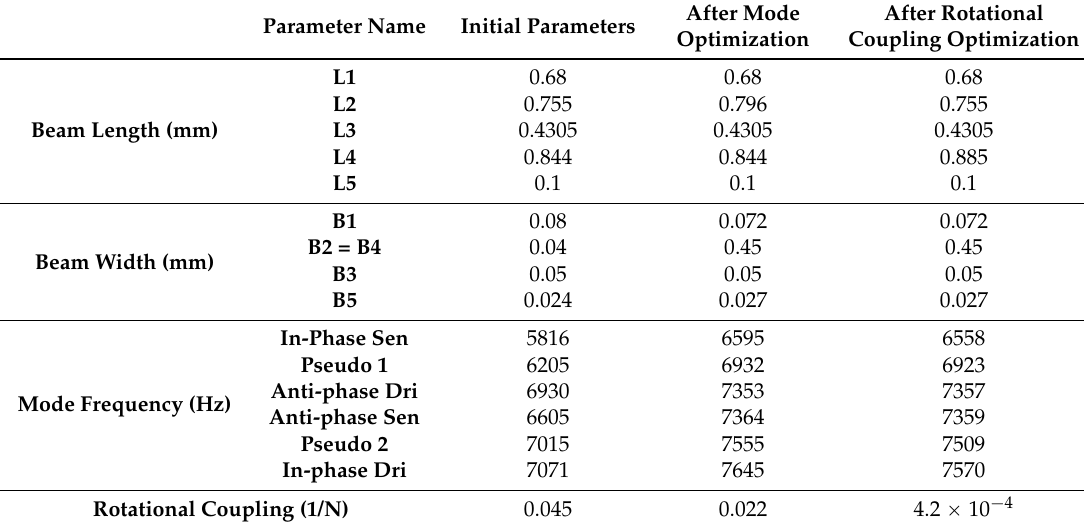
Table 3. Frequency distribution of each